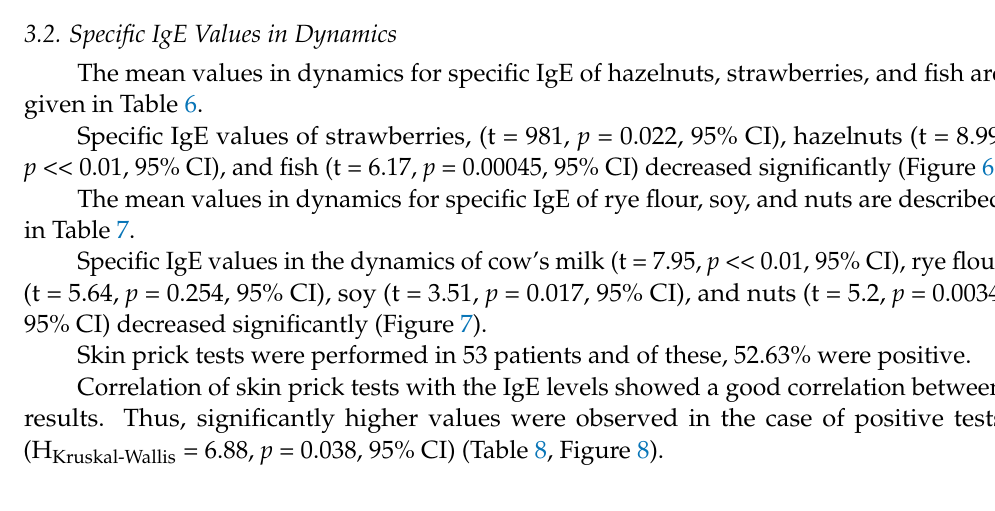
Figure 5. ROC (receiver operating characteristic) curve regarding IgE prediction specific to cow’s milk vs. remission of the disease.